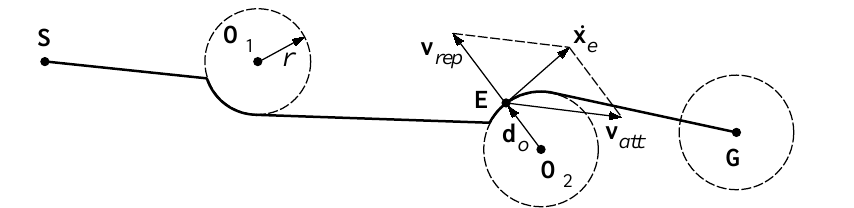
Figure 1. Potential fields for trajectory planning.